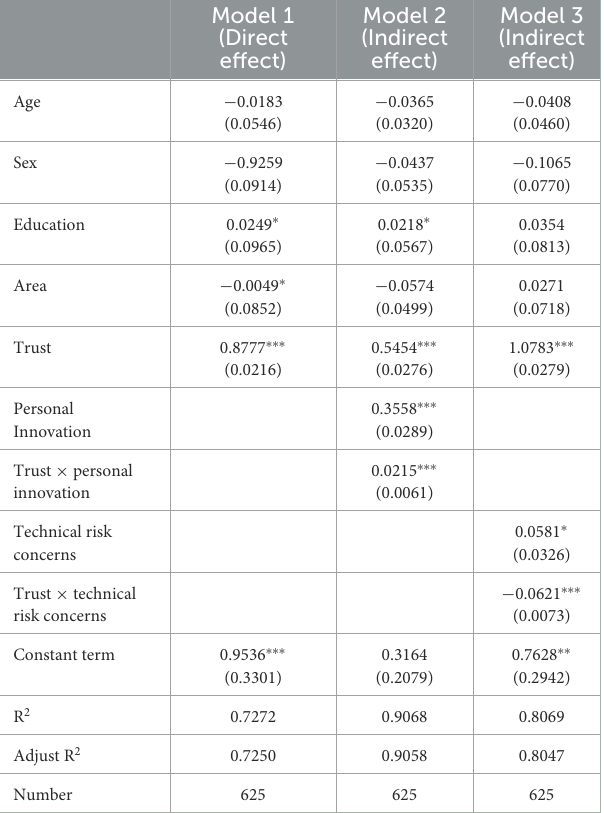
TABLE 5 Regression analysis